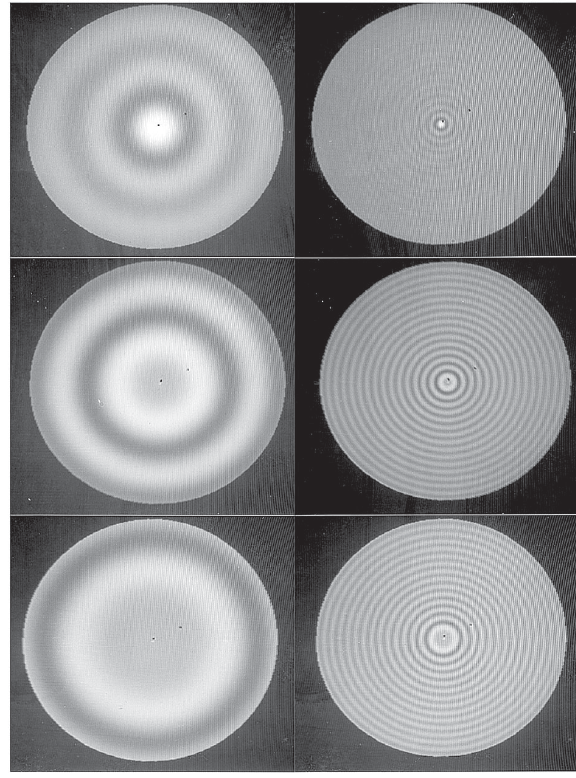
Figure 5. Stimuli defined by spherical Bessel function profiles originally taken for n = 0 (top left), n = 1 (top right), n = 2 (center left), n = 4 (center right), n = 8 (bottom left) and n = 16 (bottom right) at 1-cpd radial frequency as calibrated under the specific experimental